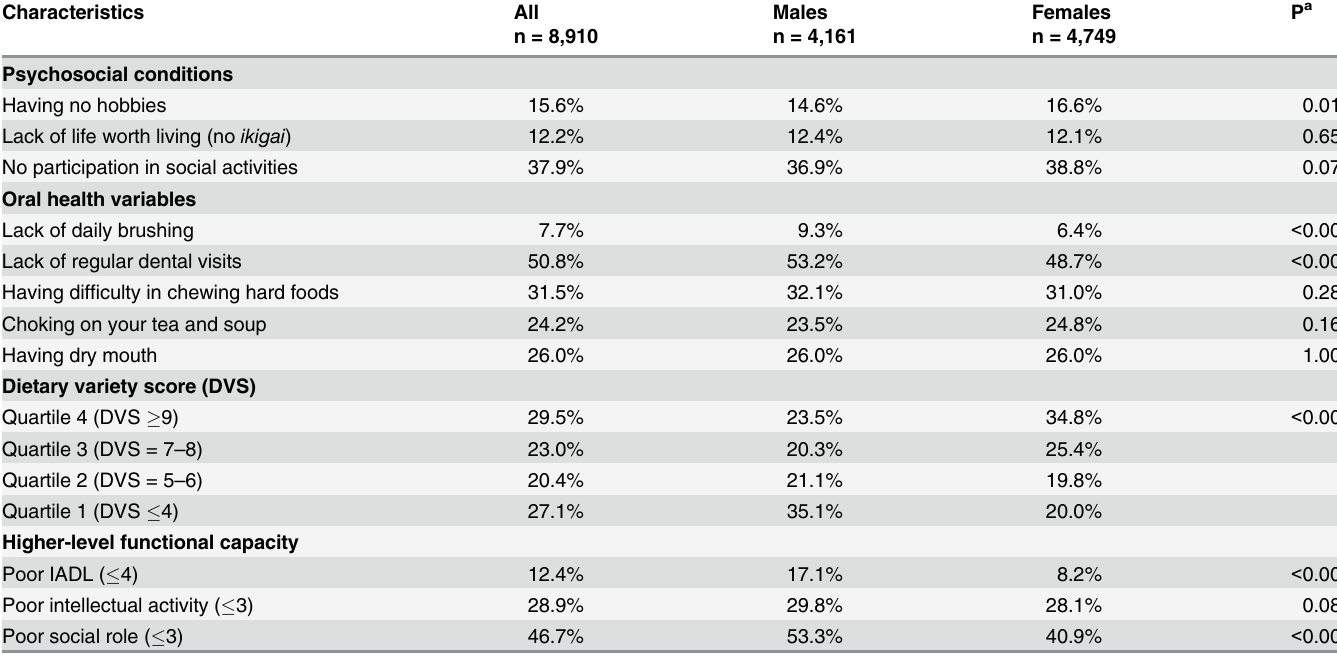
Table 1. Psychosocial Conditions, Oral Health, Dietary Variety, and Higher-level Functional Capacity among Study Participants according to